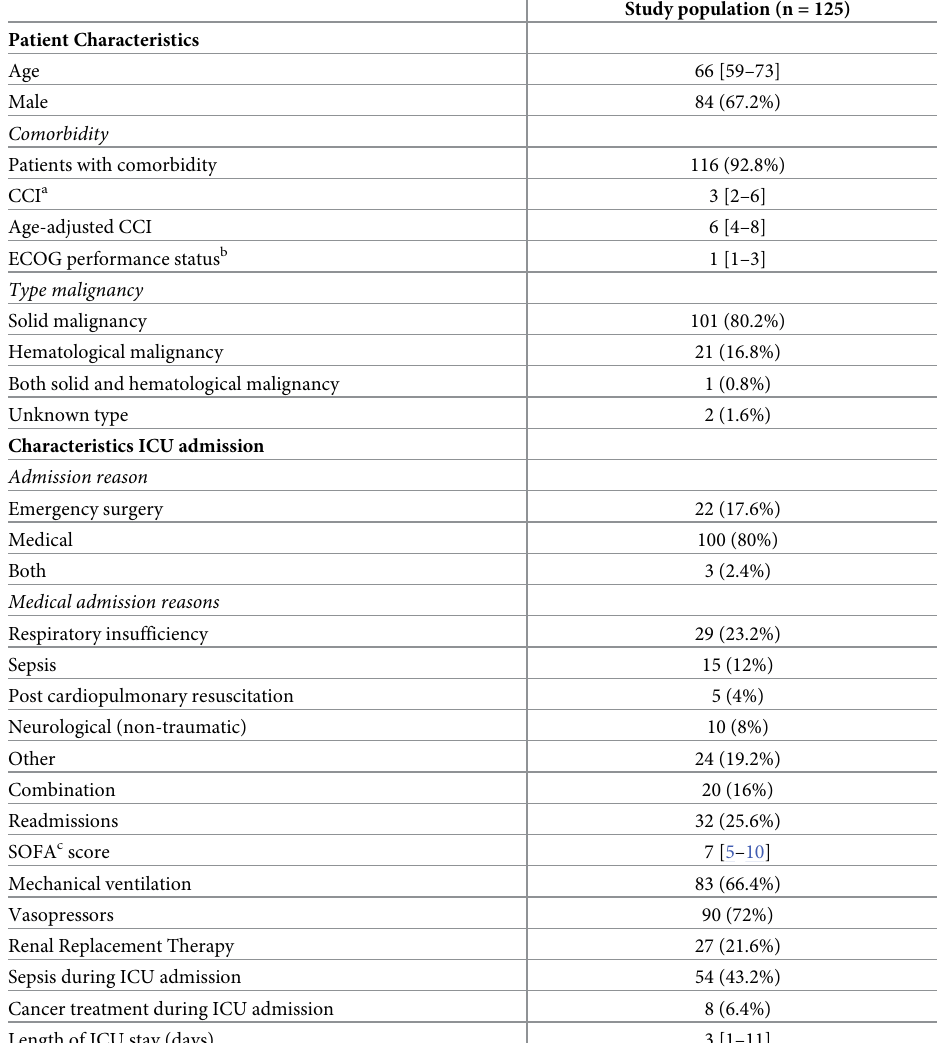
Study population (n = 125)